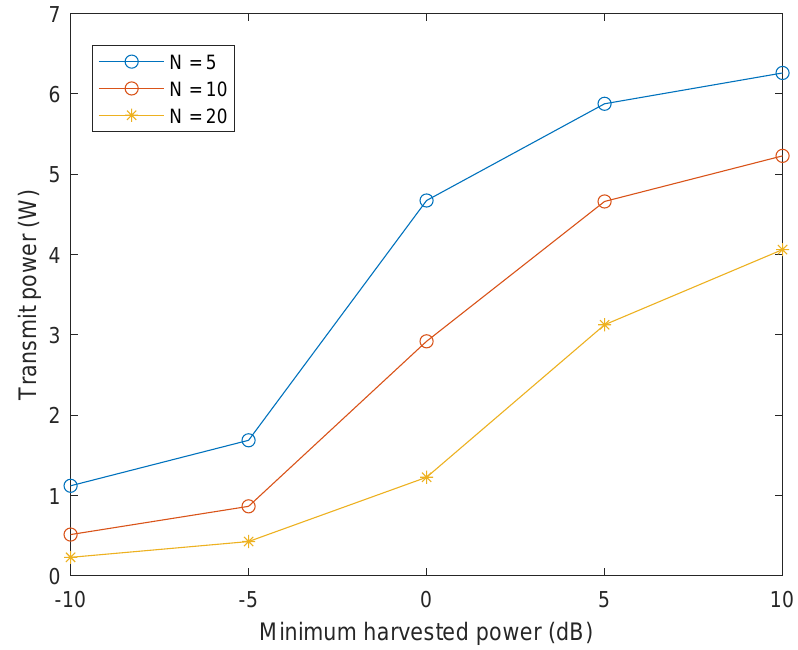
Figure 6. Transmitting power versus minimum harvested